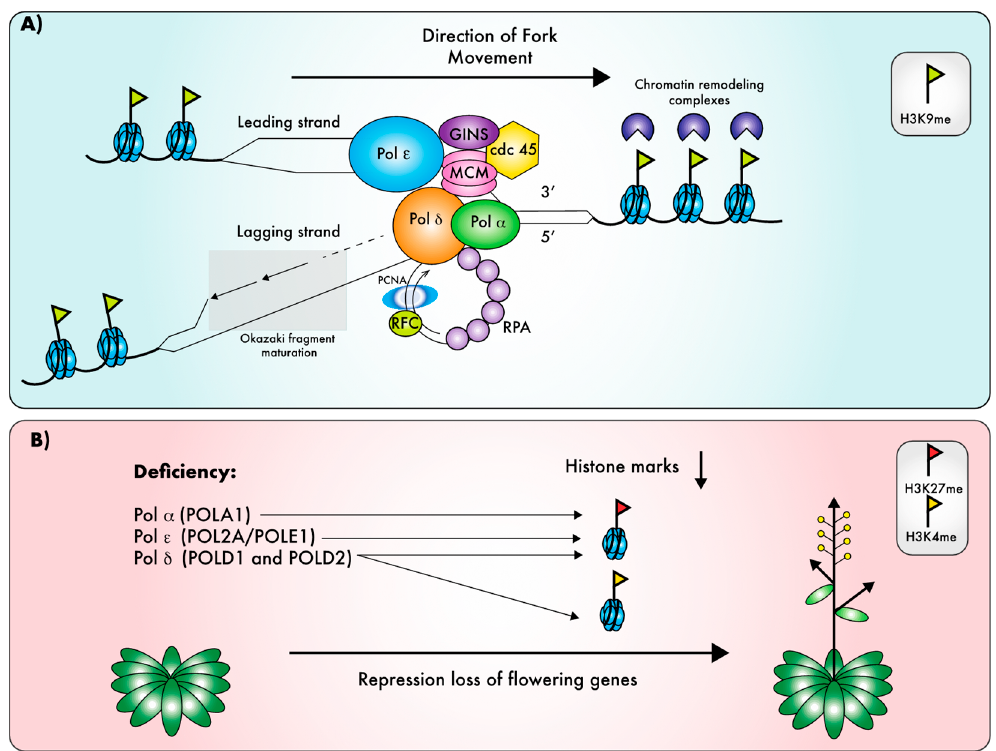
Figure 3. Roles of replicative DNA polymerases in the maintenance of epigenetic information. In addition to replicating DNA, the three plant replicative DNA Pols are involved in the replication of chromatin marks. ( A ) During DNA replication, chromatin is disrupted ahead of the replication fork, and the epigenetic information must be restored behind the fork, in order for chromatin marks to be inherited through DNA replication. ( B ) Hypomorphic mutants for replicative DNA polymerases showing early flowering caused by de-repression of flowering genes, due to defects in the maintenance of the inhibitory histone marks H3K27me for mutants of three polymerases [38–41,43,48,52,53]. In addition, loss of Pol δ mutants also affects the active H3K4me mark [40].